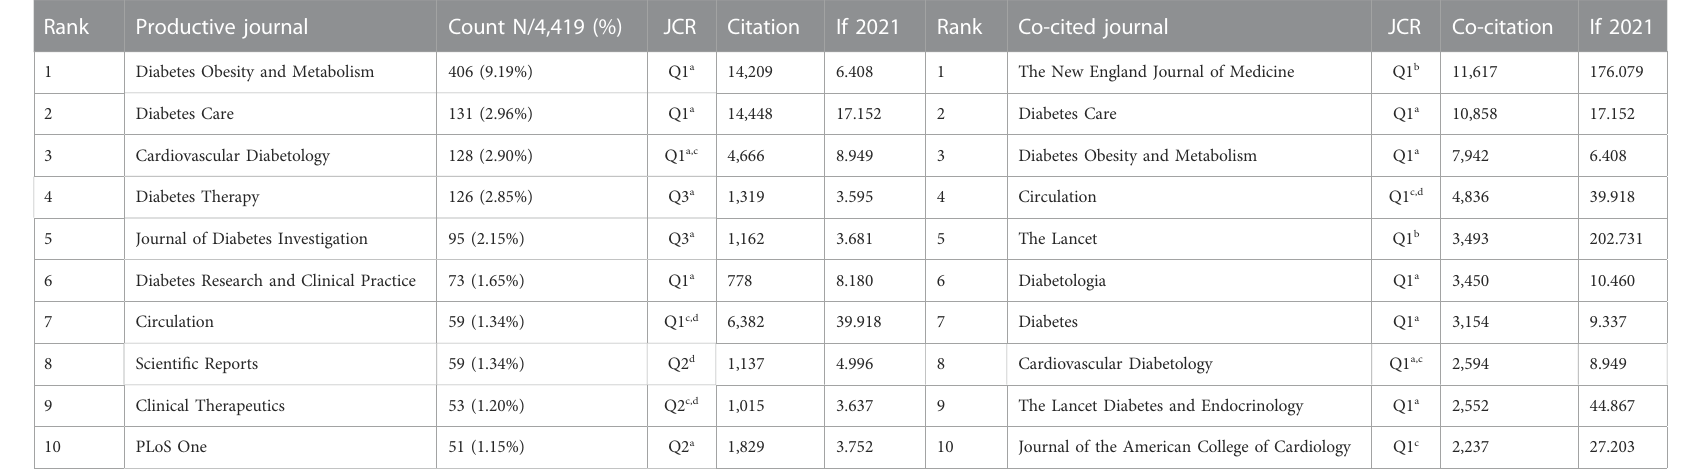
TABLE 1 Top 10 productive journals and co-cited journals in SGLT2 inhibitor